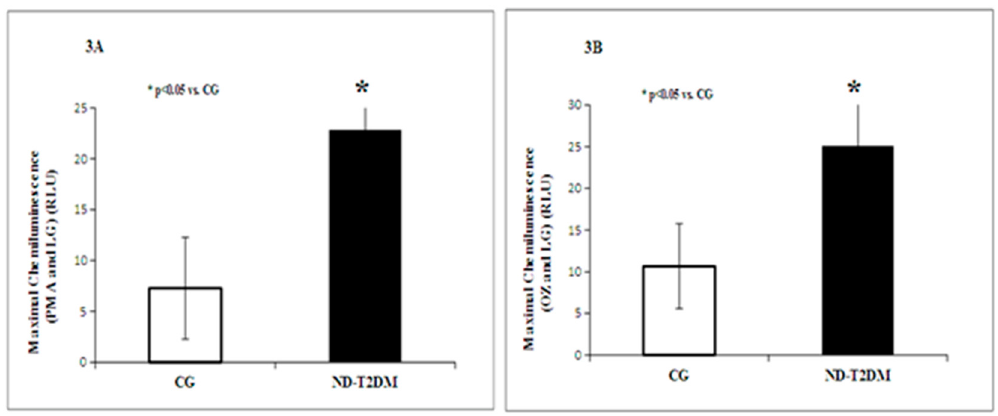
Figure 3. Respiratory burst (PMA and LG) ( A ) and (OZ and LG) ( B ) in patients with ND-T2DM versus control group (CG).